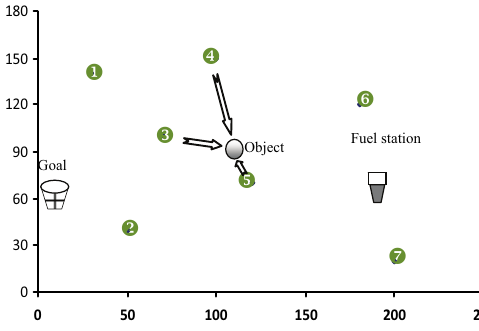
Fig. 4. Final solution of problem case 1 (first set of fuels)